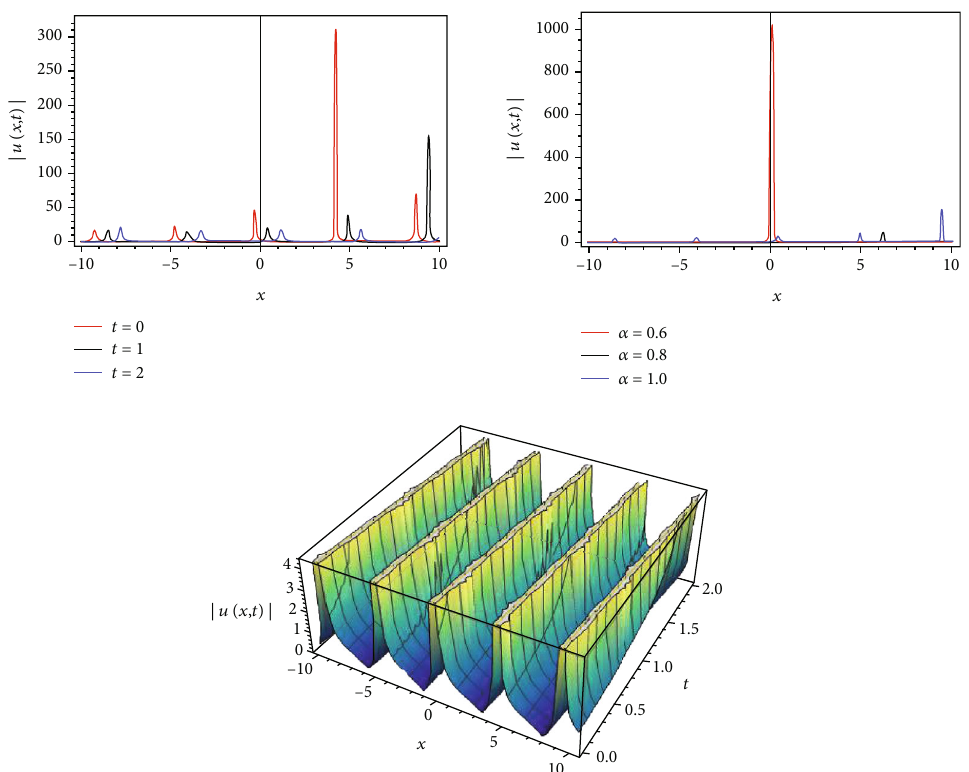
Figure 9: 2D and 3D graphics of Case 2 for trigonometric traveling wave solution (57) at f α = 0 : 6, k = 0 : 7, q = 1, s = 1, C = 1, c = 0 : 5 g :